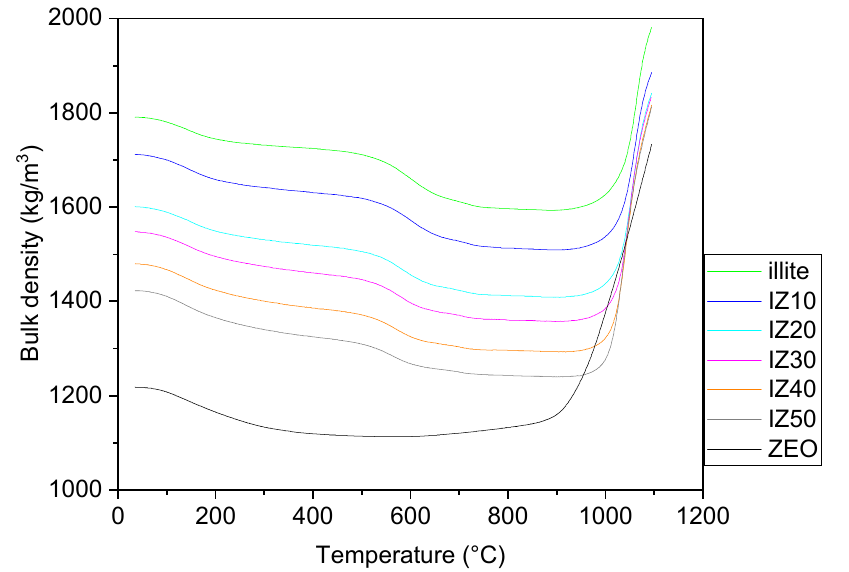
Figure 7. Bulk density of the samples.